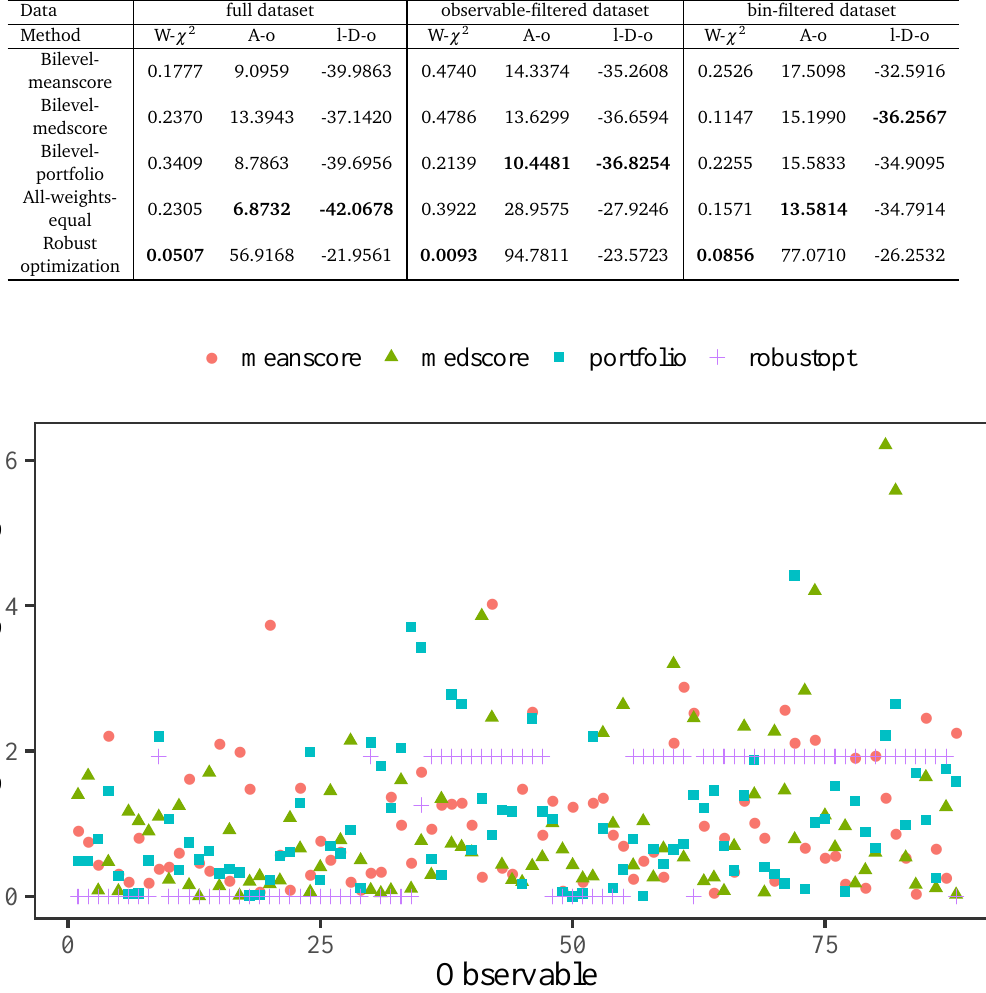
Figure 19: Distribution of weights assigned to observables for the different fitting methods described in the paper. Observables to the left are based on kinematic prop- erties of events, while those to the right are particle